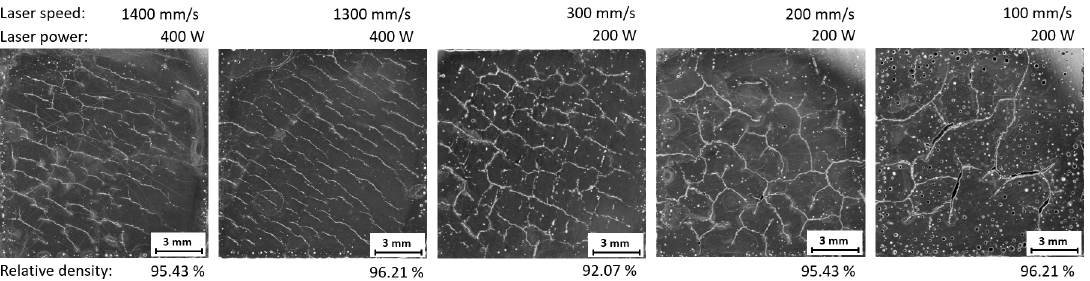
Figure 13. Metallography of samples with higher platform heating and meander strategy.